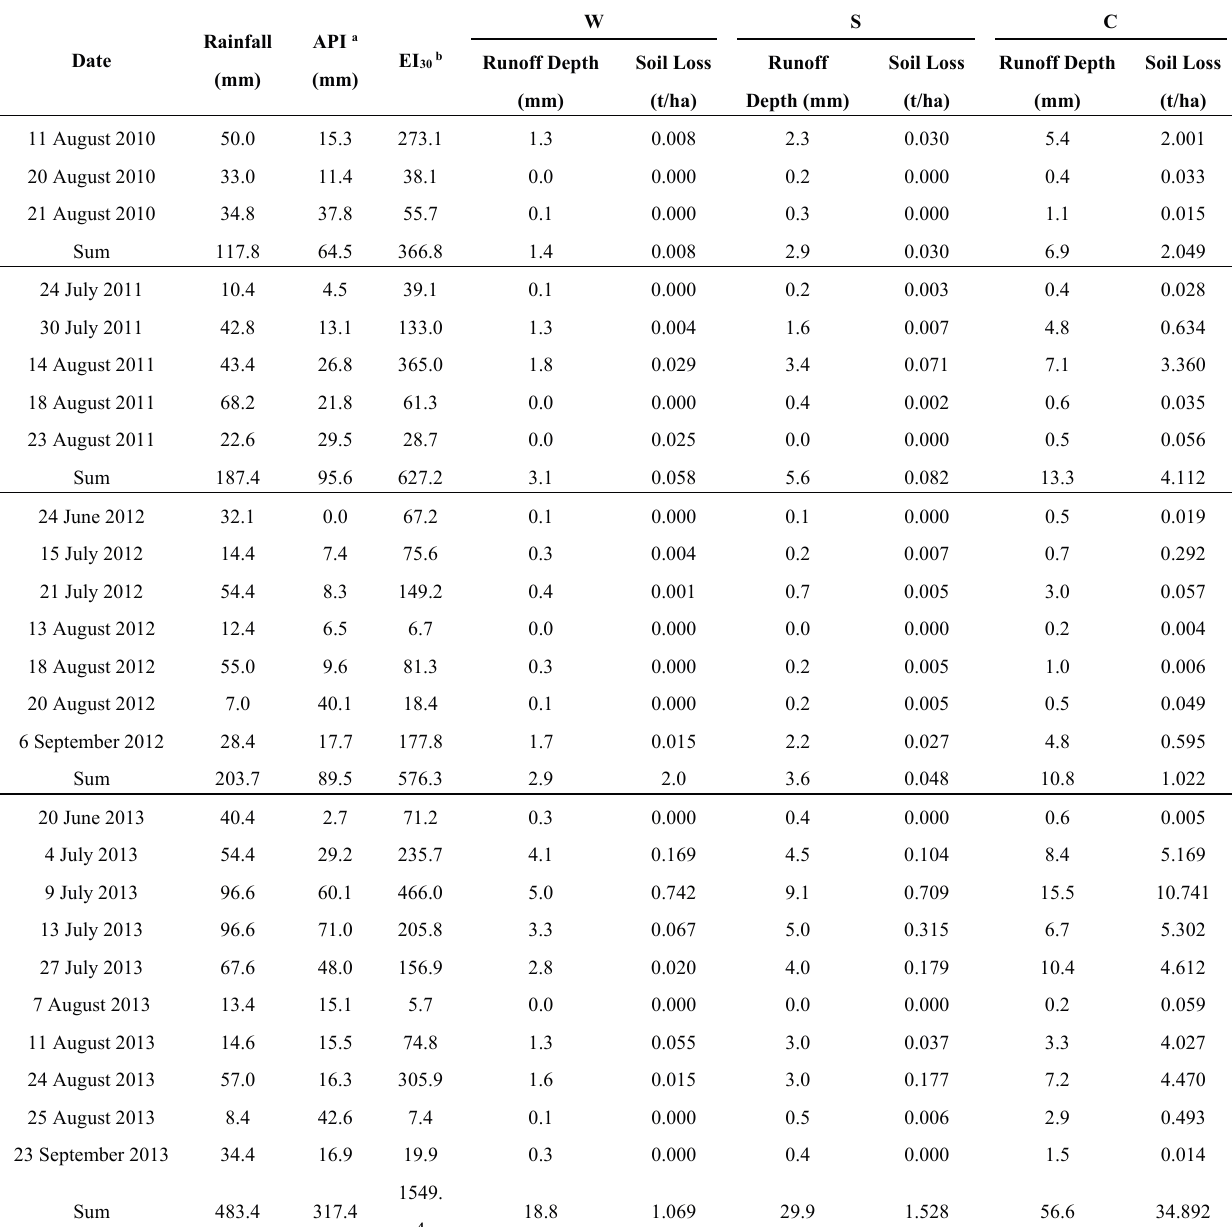
Table 1. Runoff depth and soil losses in rainfall events from 2010 to